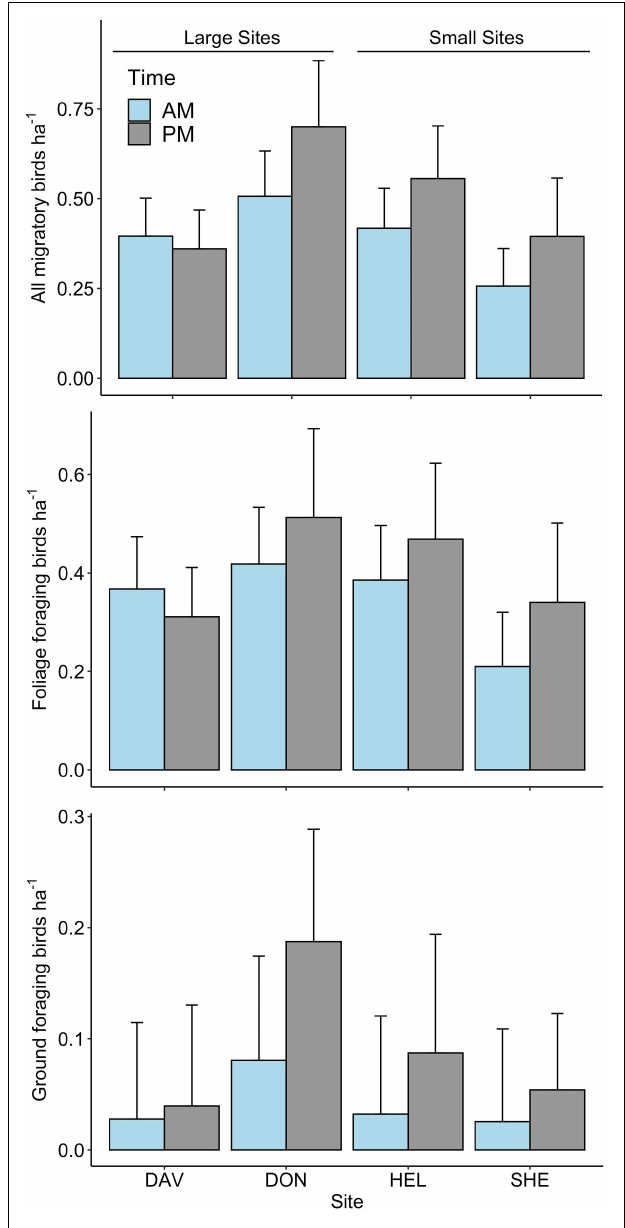
FIGURE 2 | Morning and afternoon densities of all migratory birds, foliage foraging (canopy, sub-canopy, or understory) migratory birds, and ground foraging migratory birds throughout spring migration of 2011 and 2012 at forested stopover sites in coastal Mississippi.